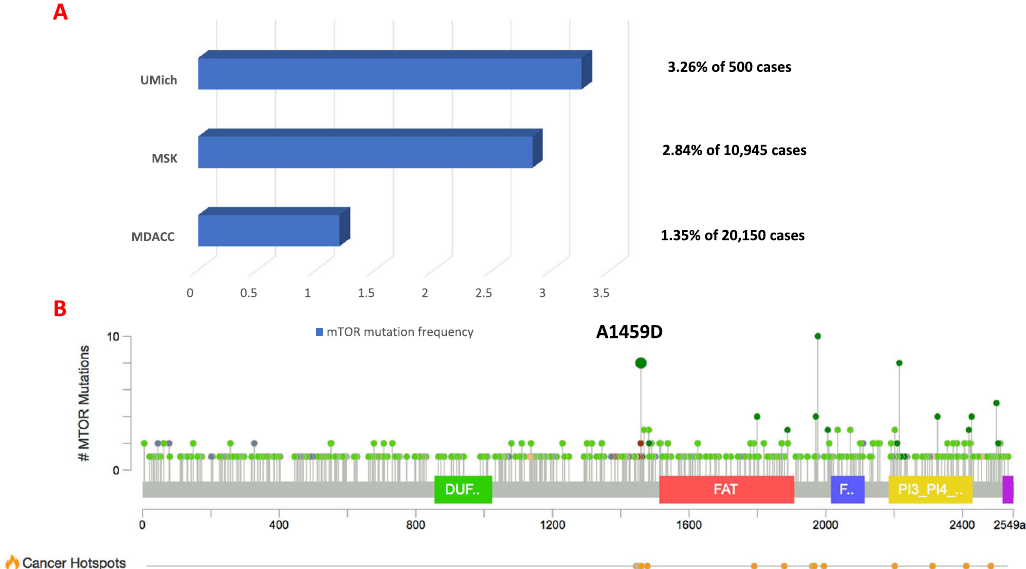
Fig. 3 Frequency of mTOR mutations. A Interrogation of IPCT database in MDACC found that of 20,150 patients sequenced, 273 cases of mTOR mutation were identi fi ed; cbioportal was used to identify the frequency in other datasets, including Metastatic Solid Cancers (UMich, Nature 2017) and the MSK-IMPACT Clinical Sequencing Cohort (MSKCC, Nat Med 2017) 46,47 . B Lollipop plot showing the distribution of mTOR mutations, including the mTOR A1459D mutation, detected in this case 46,47